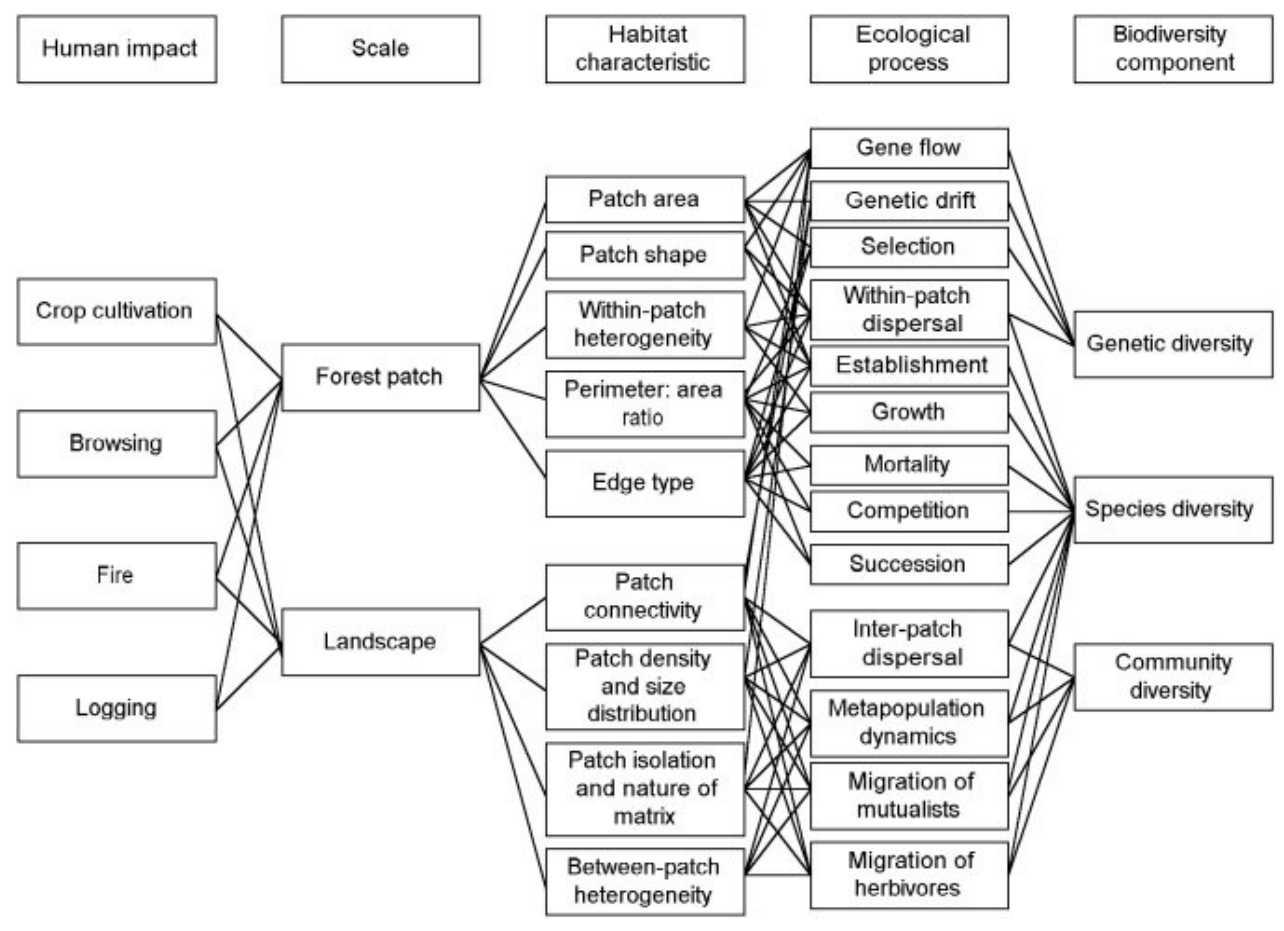
Fig. 1. Schematic diagram indicating the hypothesized impacts of different human activities on biodiversity in fragmented forest landscapes. Human activities influence forest habitat characteristics at a range of scales, which in turn affect the key ecological processes influencing the different components of